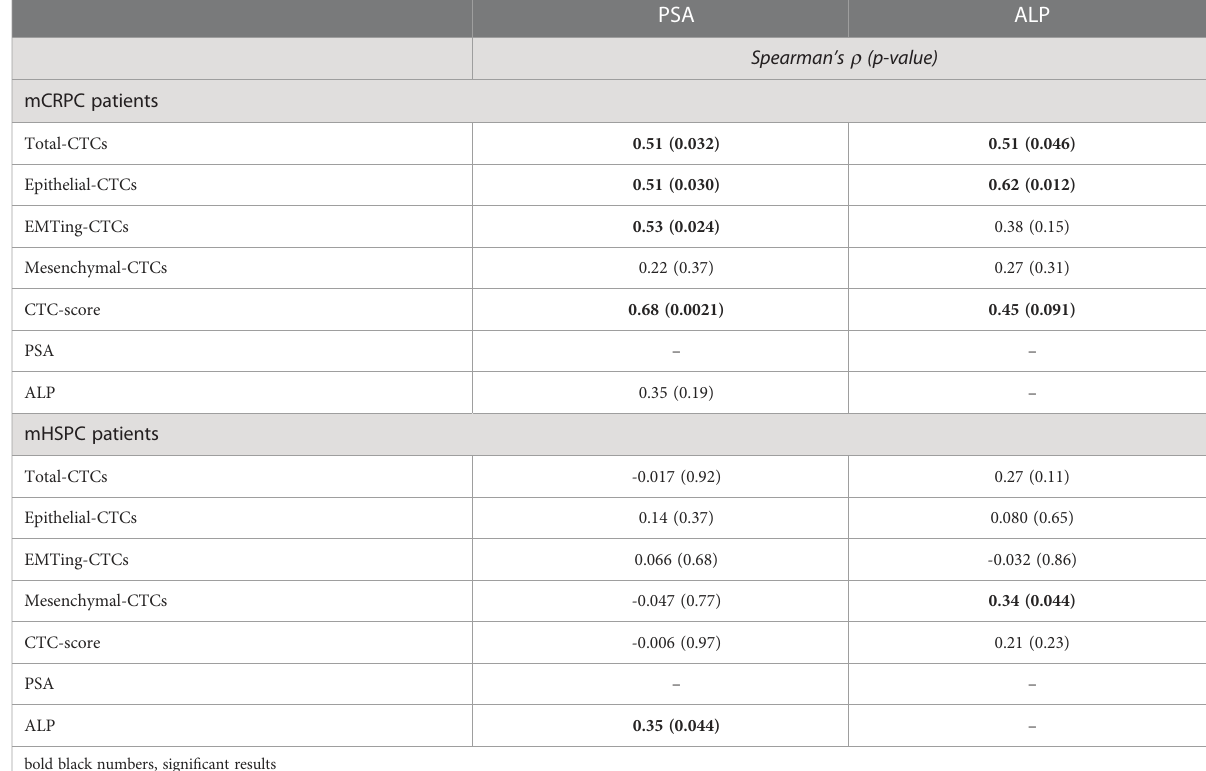
TABLE 2 Spearman ’ s correlation between CTCs and serum PSA and ALP.